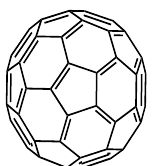
Figure 4. Idealized structure of the fullerene C60